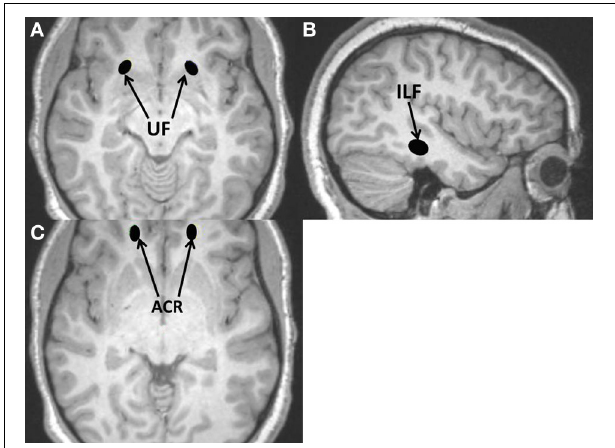
FIGURE 2 | Additional regions of interest (ROIs) used for DTI measurements placed on anatomical T1-weighted MRI scan; all are non-auditory ROIs. (A) Uncinate fasciculus (UF); (B) Inferior longitudinal fasciculus (ILF); (C) Anterior corona radiata